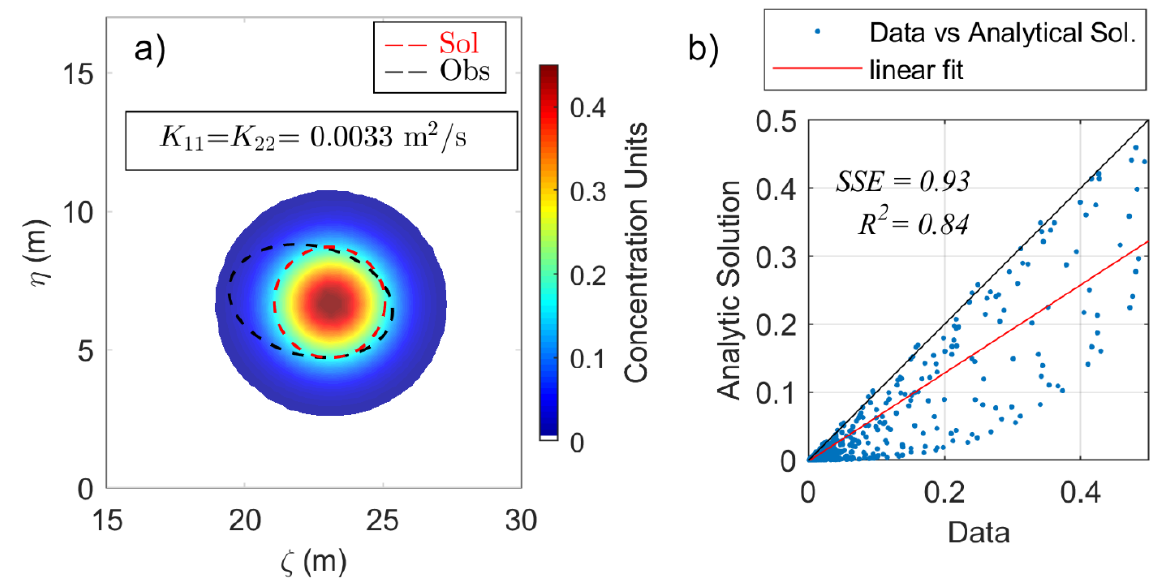
Figure 8. ( a ) Concentration contours obtained with optimal diffusion coefficients for 𝐾 11 = 𝐾 22 . Observations are shown in black and the solution in red. In ( b ), the dispersion diagram of the data and the analytical solution with SSE and 𝑅 2 is shown.